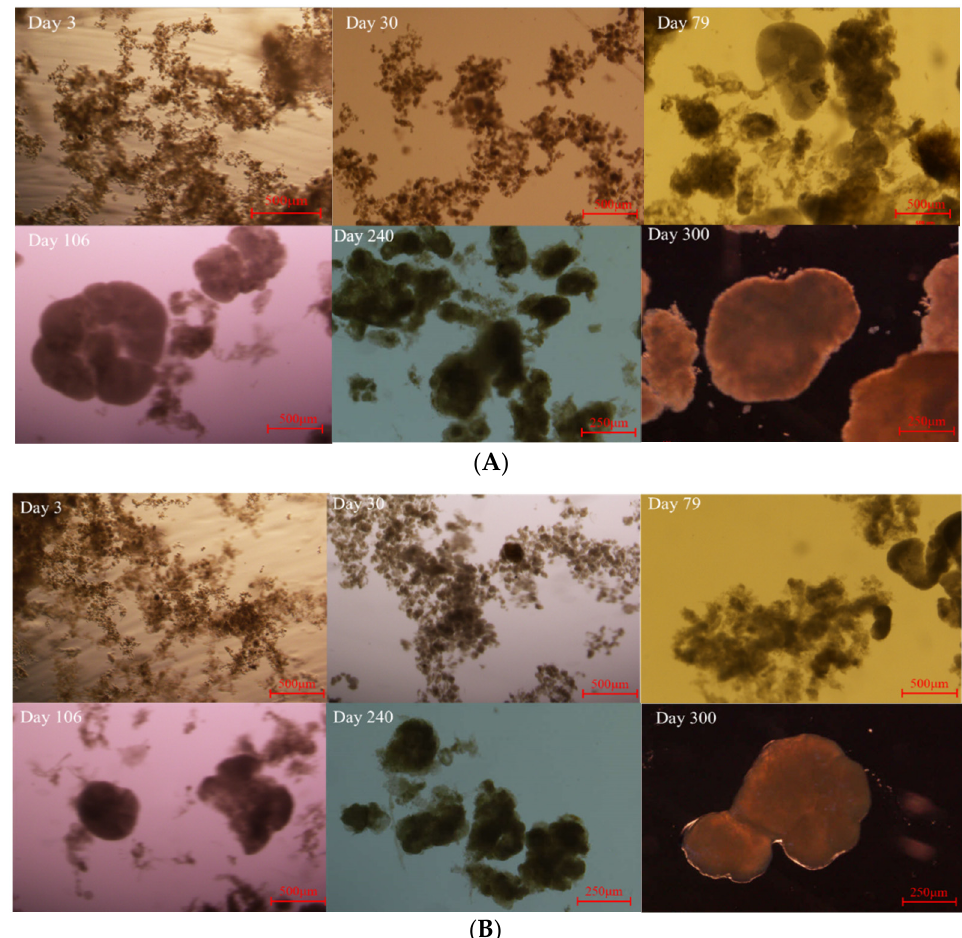
Figure 1. Morphology of the sludge on different days of the operation. ( A ) in R1; ( B ) in R2.